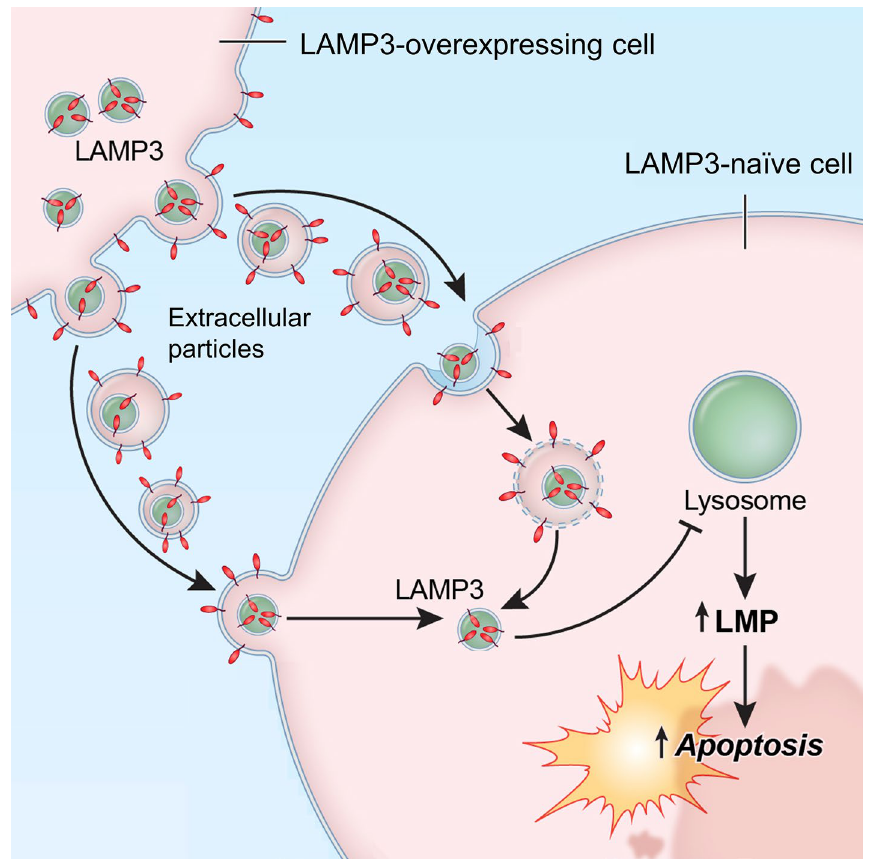
Figure 8. Graphical summary. Extracellular particles containing LAMP3 are released by LAMP3- overexpressing cells and taken up by a neighboring LAMP3-naïve cell. This results in LAMP3 protein transfer to the cytoplasm of the naïve cell. Here, LAMP3 induces lysosomal membrane permeabilization (LMP), leading to apoptotic cell